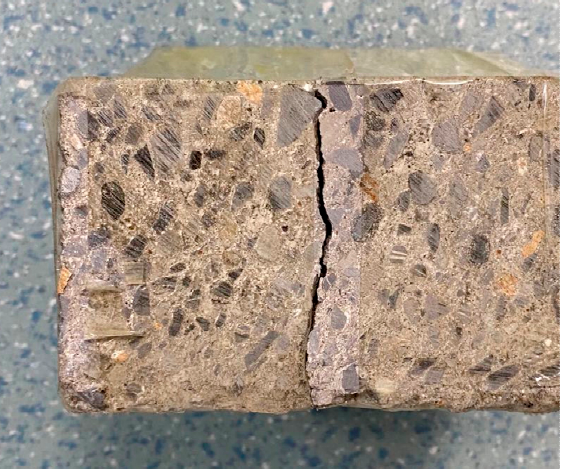
Figure 13. The unburned concrete sample after the impact test (3 m high; drop mass: 40 kg). CT scanning was performed for the unburned concrete test block with a size of 150 × 150 × 150mm. The thickness of CT scanning is 1 mm. After the initial scanning, 120 CT images were obtained for each concrete test block. The obtained CT images were extracted and analyzed by the MATLAB program. MATLAB provided the imread function to record the RGB value of the pixels in the image. Next, the obtained RGB images were transformed into the gray images by the rgb2gray function. There are many methods of gray processing. The algorithm of the weighted average of the RGB value was adopted in MATLAB. After the image was binarized, the image edge (edge function) was obtained by the edge function (Figure 14).